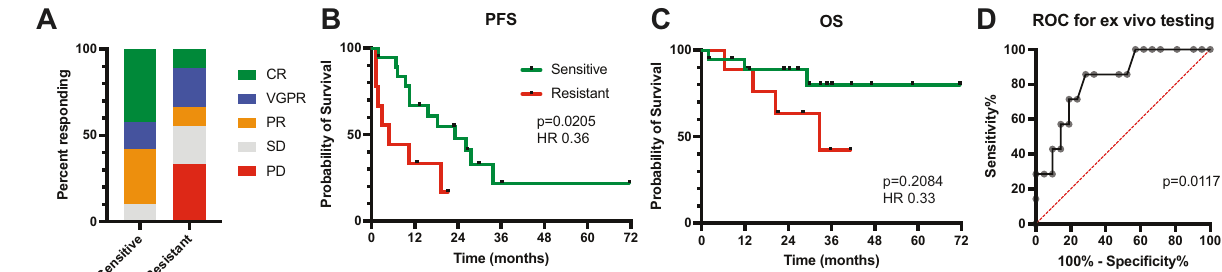
Fig. 1 Patient outcomes based on ex vivo venetoclax testing. Pre-treatment bone marrow aspirates were tested ex vivo for venetoclax sensitivity as described previously [3]. Brie fl y, buffy coat cells were treated with increasing concentrations of venetoclax for 24 h and then assessed for apoptosis by annexin V staining to determine an IC50. An IC50 of less than 100 nM was considered sensitive, while an IC50 of greater than 100 nM was considered resistant. A Overall response rate for patients with sensitive vs. resistant ex vivo testing. B PFS and C OS of sensitive and resistant patients. D Receiver operating curve for ex vivo testing.